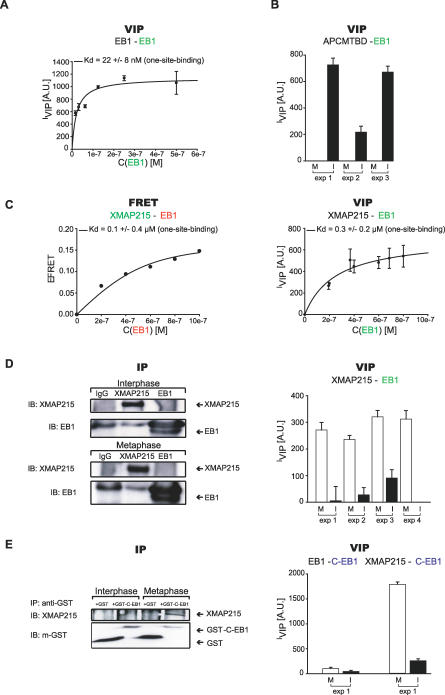
Validation of VIP Assay(A) VIP binding isotherm of EB1-EGFP to αEB1-antibody interaction fitted with a one site–binding model. A.U., arbitrary units.(B) Interaction of EB1-EGFP (prey: EGFP protein added to the extract) with APCMTBD (bait: recombinant protein added to the extract that binds to the anti-APC–coated beads) in metaphase (M, open bars) and interphase (I, filled bars). The three pairs of bars correspond to three independent experiments carried out in different extracts. A.U., arbitrary units; exp, experiment.(C) FRET binding isotherm of recombinant XMAP215-EGFP to recombinant EB1Cy3 in CSFXB buffer (left panel) and the VIP binding isotherm of recombinant XMAP215 to EB1-EGFP in CSFXB buffer (right panel). Both isotherms are fitted with one site–binding models. A.U., arbitrary units.(D) IP of XMAP215 or EB1 (left panel) and XMAP215/EB1-EGFP VIP (right panel) in interphase and metaphase extracts. Co-precipitation of EB1 or XMAP215 in IP experiments was probed by SDS-PAGE/immunoblotting with the respective antibodies (immunoblot [IB] with XMAP215 antibody and with EB1 antibody). In the VIP experiment, endogenous XMAP215 served as bait and EB1-EGFP as fluorescent prey. In the right panel, the four pairs of bars correspond to four independent experiments performed in metaphase (M, open bars) and interphase (I, filled bars) extracts. A.U., arbitrary units; exp, experiment.(E) Left panel shows IP pull down of 2 μM GST and GST-C-EB1 using apolyclonal αGST antibody. Co-precipitation of XMAP215 was probed by SDS-PAGE/immunoblotting with the XMAP215 antibody (IB: XMAP215). Immunoblot (IB) with monoclonal αGST antibody (m-GST) shows that GST and GST-C-EB1 were added to interphase and metaphase extracts accordingly. Right panel shows the VIP experiment of EB1-GST-C-EB1Cy5 and XMAP215-GST-C-EB1Cy5 in metaphase (M, open bars) and interphase (I, filled bars) extracts. Error bars represent the s.e.m. of <IVIP> derived from at least three different microscopic fields. A.U., arbitrary units, exp, experiment.